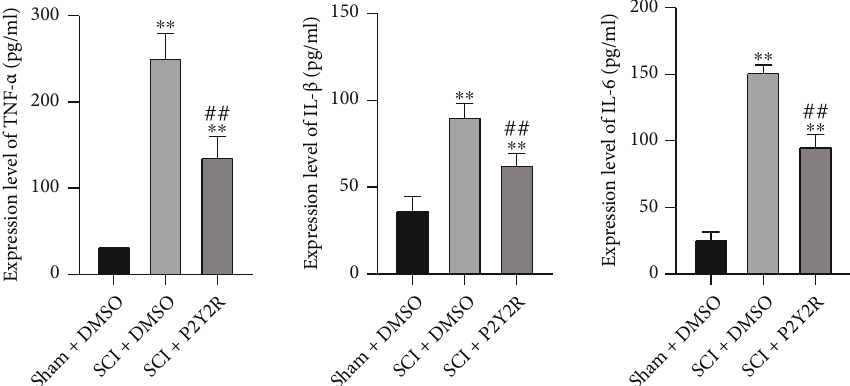
Figure 4: The expression levels of TNF- α , IL-1 β , and IL-6 detected by ELISA. ∗ p < 0 : 05 and ∗∗ p < 0 : 01 compared with the sham+DMSO group; ## p < 0 : 01 compared with the SCI+DMSO